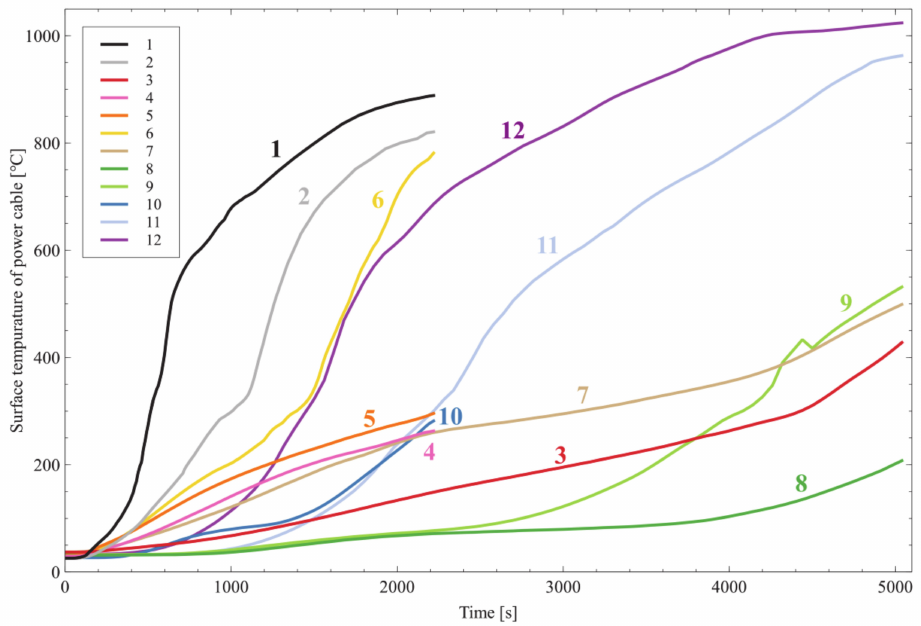
Figure 9. Power cable’s surface temperature curves for 12 cases.